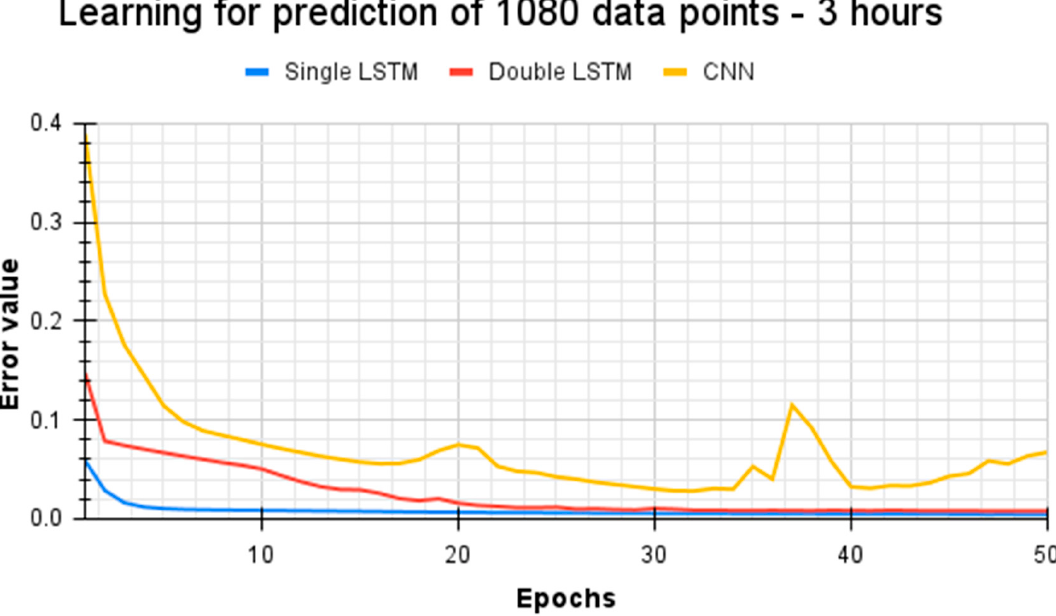
Figure 7. Comparison of the learning process of different types of LSTM and CNN networks in the 2 h forecasting horizon: X -axis—next epochs, Y -axis—error level.